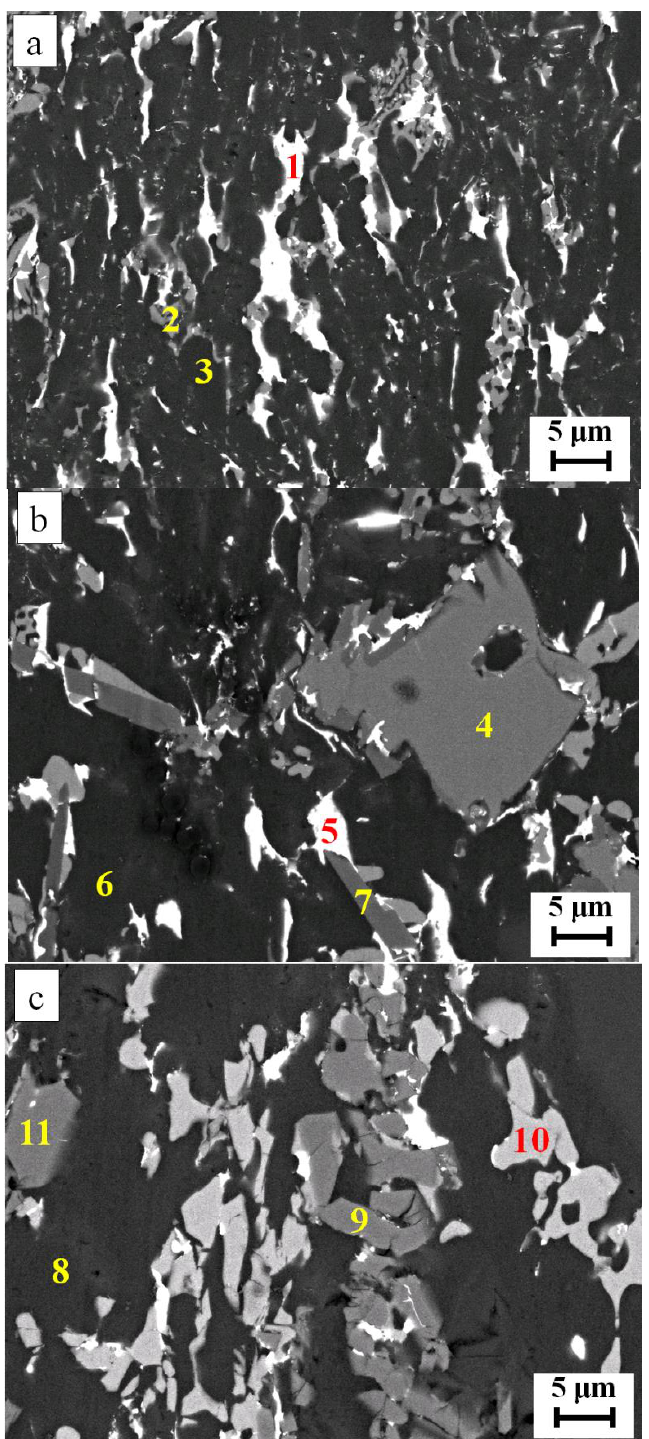
Figure 2. Microstructures under BSE mode of the as-solidified ( a ) Al10.8Si10Cu, ( b ) Al10Si10Cu4Ti and ( c ) Al10Si10Cu0.1RE filler alloys.